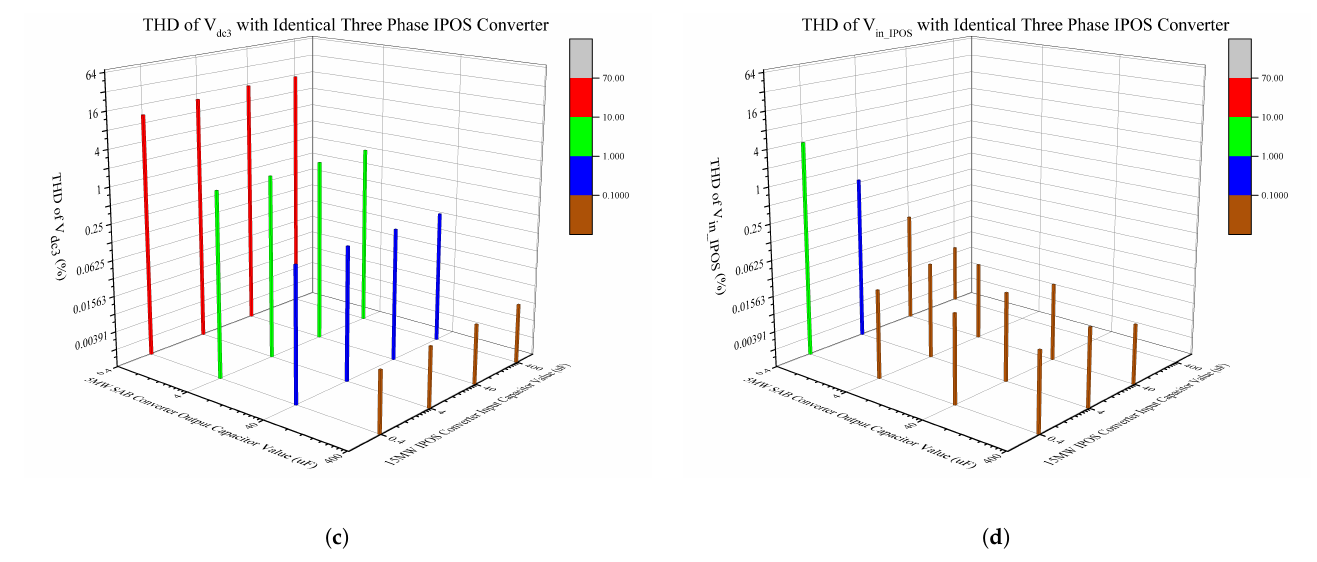
Figure 6. Total harmonic distortions of terminal voltages in Figure 2 in different filter capacitor values with Identical Three Phase IPOS Converter. ( a ) Total harmonic distortions V dc1 ; ( b ) total harmonic distortions V dc2 ; ( c ) total harmonic distortions V dc3 ; and ( d ) total harmonic distortions V in_IPOS